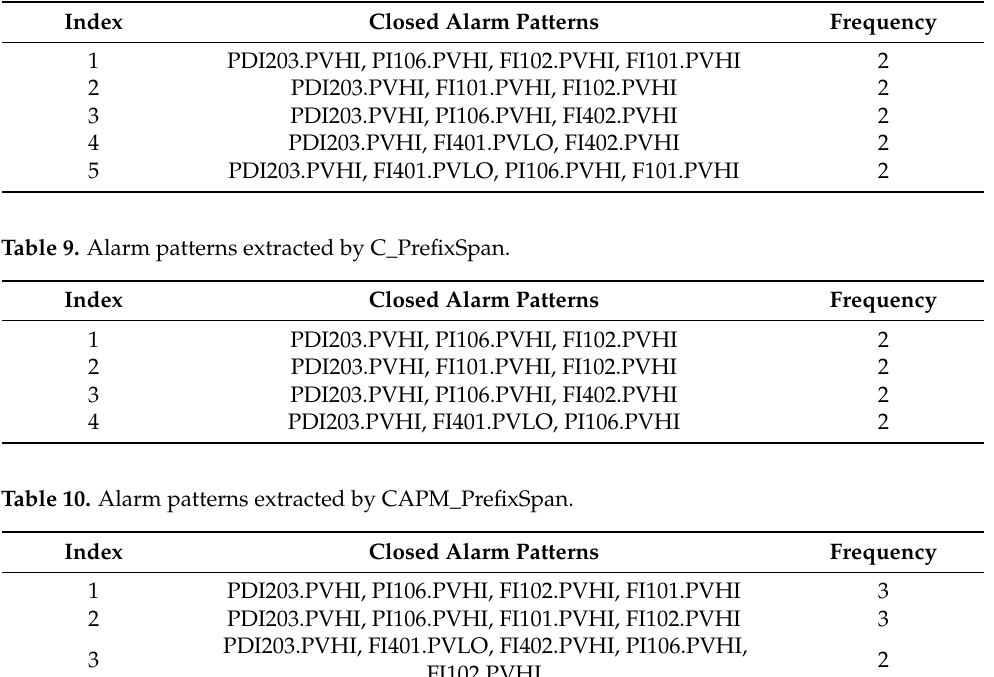
Table 8. Alarm patterns extracted by M_PrefixSpan.